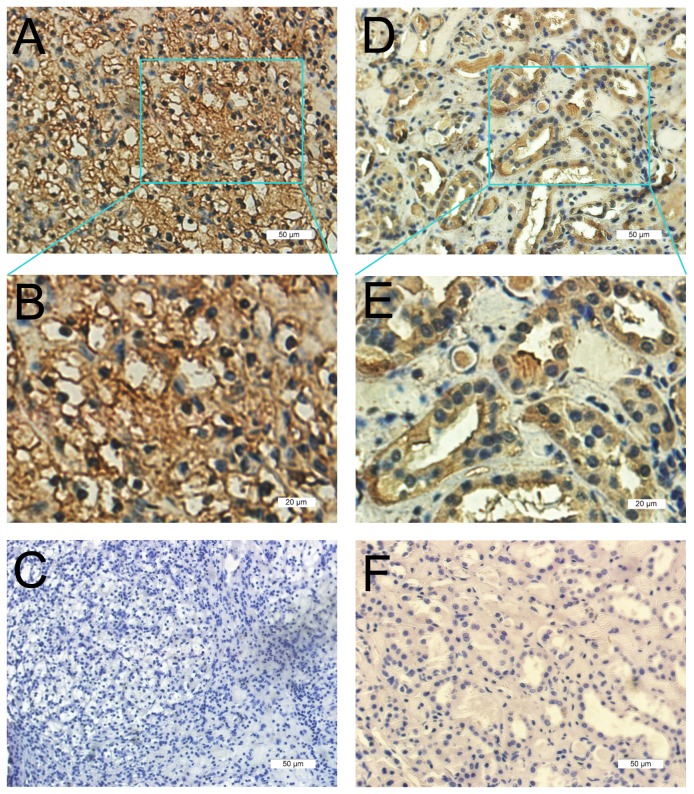

ccRCC
 tissues(38 cases) and their corresponding adjacent non-cancerous kidney tissues were immunohistochemically stained by E2F1 antibody(1:100).Three representative photographs were taken at different magnifications in ccRCC tissues(A-B: 200× A, 400× B and negative control of tumor cells of C) and corresponding adjacent non-cancerous kidney tissues(D-E:200× D,400×E and negative control of normal renal tubules cells of F) respectively.